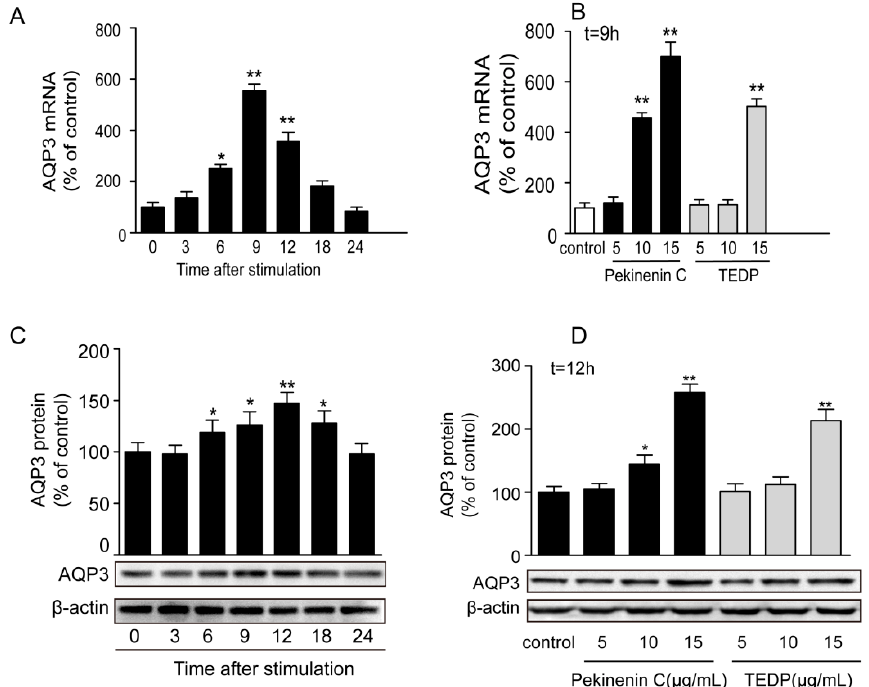
Figure 5. Changes in mRNA expression levels ( A ) and protein expression levels ( B , C ) of AQP3 in the HT-29 cells after the administration of Pekinenin C and TDEP; ( A ) Expression level of AQP3 mRNA intreated by Pekinenin C (15 µ g/mL) for different times (0, 3, 6, 9, 12, 18 and 24 h, respectively); ( B ) Expression level of AQP3 mRNA in HT-29 cells treated by Pekinenin C and TDEP at different dosages (5, 10 and 15 µ g/mL, respectively) for 3 h. The results were normalized with β -actin level, and AQPs mRNA level of the control was taken as 100%; ( C ) Expression level of AQP3 mRNA intreated by Pekinenin C (15 µ g/mL) for different times (0, 3, 6, 9, 12, 18 and 24 h, respectively); ( D ) Expression level of AQP3 protein in HT-29 cells treated by Pekinenin C and TDEP at different dosages (5, 10 and 15 µ g/mL, respectively) for 12 h. The results were normalized with β -actin protein level, and AQP3 protein level of the control was taken as 100%. Data were represented as the mean ± SD. * p < 0.05, ** p < 0.01 vs. control group, respectively. n = 3 in each group and each assay was repeated six times.